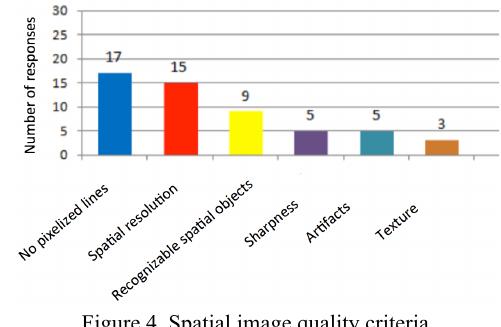
Figure 4. Spatial image quality criteria